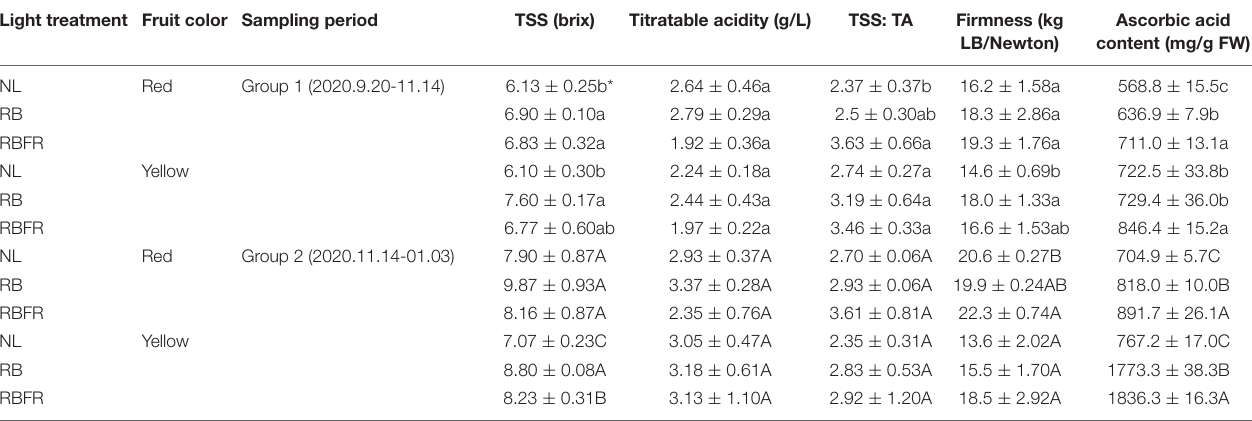
TABLE 3 | Total soluble sugar (TSS), titratable acidity (TA), TSS: TA, firmness, and ascorbic acid content of the sampled fruits of sweet peppers grown under natural light (NL), NL with red + blue LED interlighting (RB), and RB with additional far-red light (RBFR). Light treatment Fruit color Sampling period TSS (brix) Titratable acidity (g/L) TSS: TA Firmness (kg